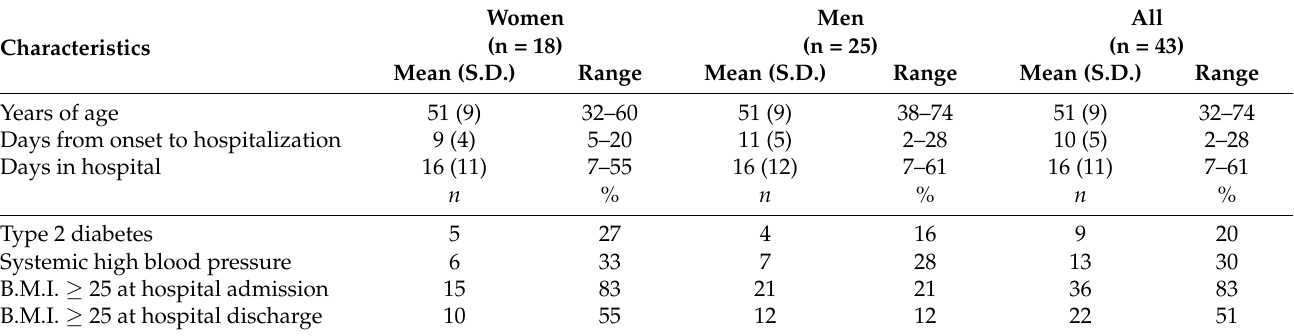
Table 1. General characteristics of the 43 patients included in the